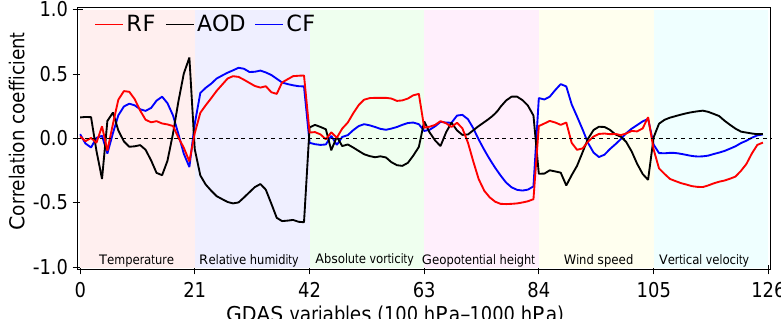
Figure 10. Correlation coefficients of accumulated daily rainfall, AOD, and cloud fraction with six GDAS meteorological variables over the ISMR. Different color shades along the x axis indicate corresponding meteorological variable, and each color shade has 21 divisions, which represents the corresponding 21 model pressure levels from 100 to 1000hPa (left to right). Correlation analysis was performed at each model pressure level with all collocated samples between two variables (e.g., temperature and RF for x -axis values of 1–21 in the case of the red line) over the ISMR region for JJAS